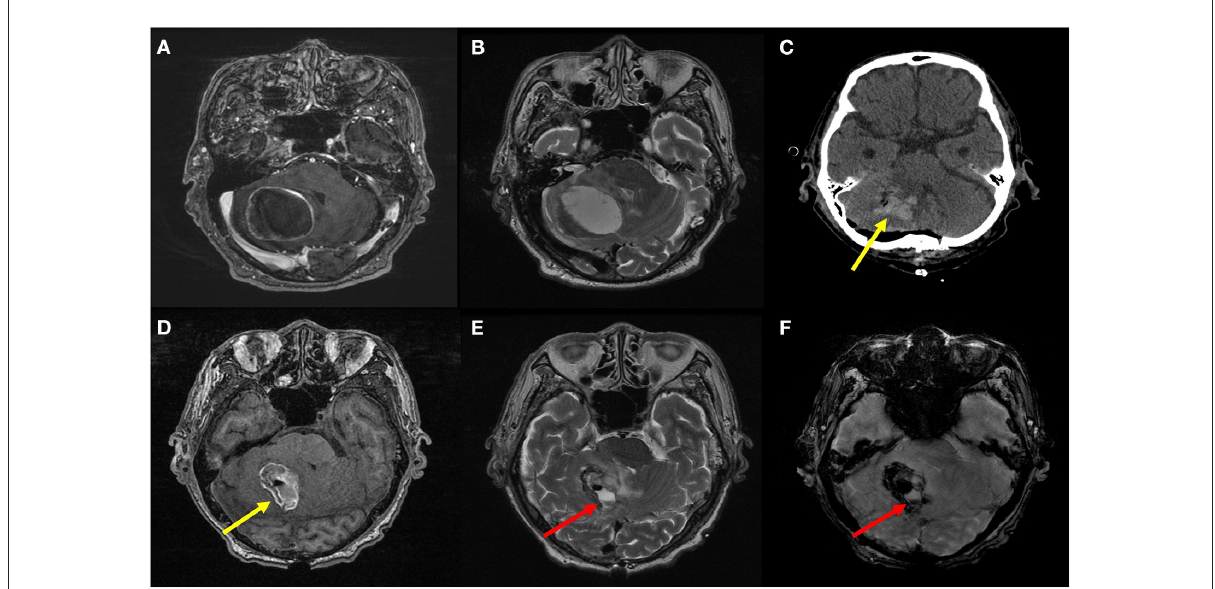
FIGURE2 Preoperative T1 contrast-enhanced (A) and T2-weighted MR images (B) of an 84-year-old male patient with advanced gastric cancer show a well-defined metastatic tumor in the right cerebellar hemisphere with peritumoral edema. On postoperative CT image (C) and non-enhanced T1-weighted (D) , T2-weighted (E) , and susceptibility-weighted (F) MR images, space-occupying hematoma (yellow arrows) as well as air bubbles are seen in the resection cavity. Furthermore, a fluid-fluid level (red arrows) is also seen in the resection cavity, which indicates hematoma formation in this context. This was considered as presence of postoperative intracranial hemorrhage. The patient experienced postoperative delirium on the third day after surgery. The motor subtype was non-hypoactive (i.e., hyperactive or mixed); hence, we observed sleep disturbance, irrelevant speech, delusion, and aggressive behavior. The sleep and behavioral problems were managed using several medications: chlorpromazine, risperidone, and